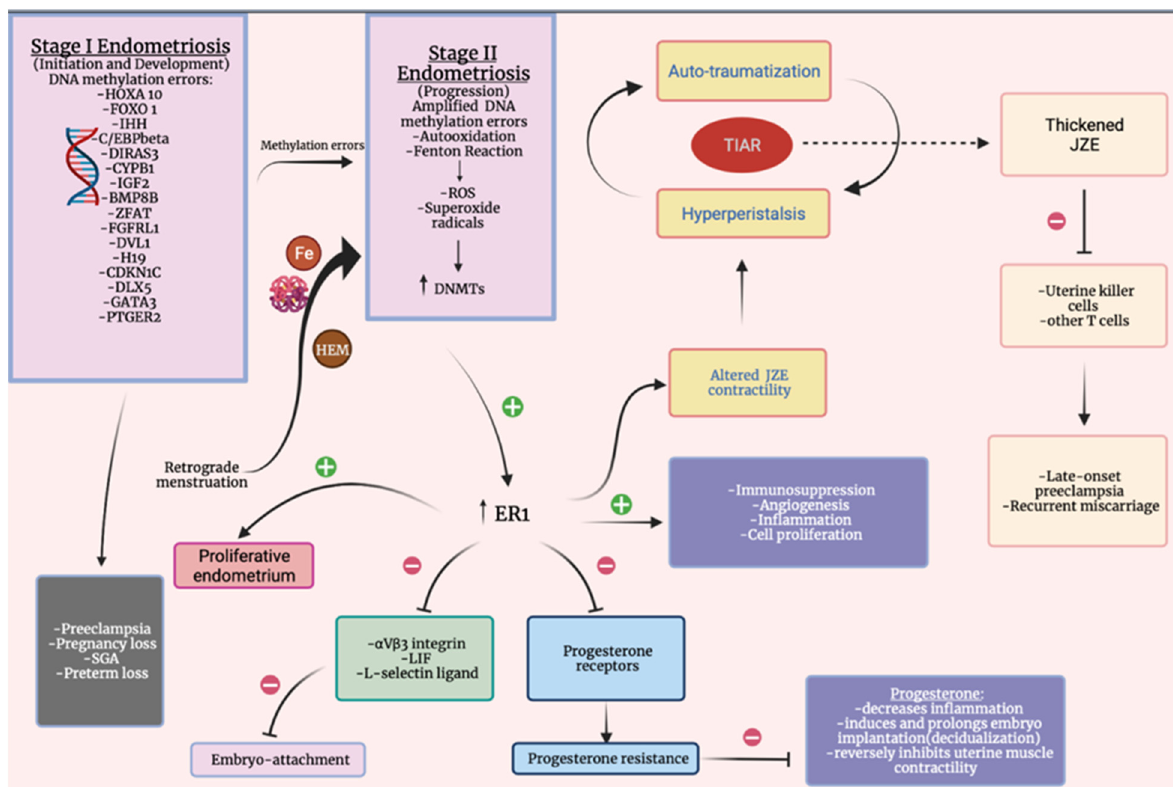
Figure 1. Representation of pathogenic mechanisms; HOXA—Homebox A gene cluster, FOXO1—forkhead box O1, IHH—Indian hedgehog signaling molecule, C/EBPbeta—CCAAT/enhancer-binding protein-beta,